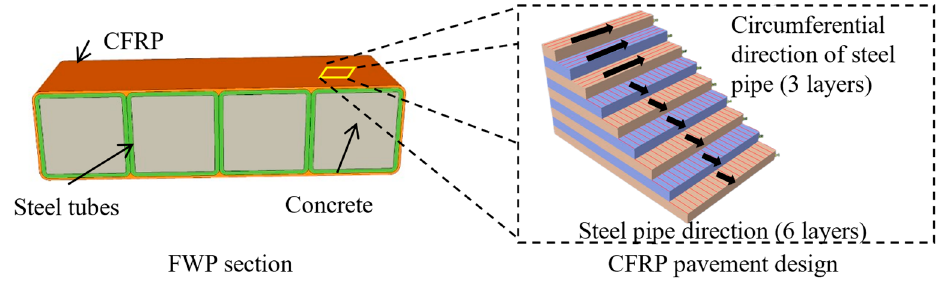
Figure 2. The section of the filament wound profiles and the pavement design of